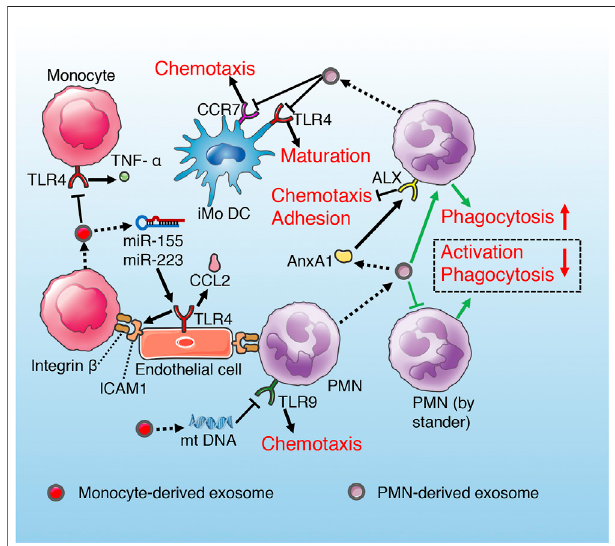
FIGURE 7 | Role of exosomes derived from monocyte and PMN in sepsis.Monocyte exosomes reduce TNF- α release ofrecipientmonocyteand PMNchemotaxis via TLRinhibition.However,exosomalmiRNAsofmonocyte promote endothelium adhesion by activating TLR. PMN-derived exosomes suppress maturation and chemotaxis of iMoDC through inhibiting CCR7andTLR4separately.PMN-derivedexosomessuppressrecipientPMN chemotaxis and adhesion to endothelium via AnxA1/ALX pathway. In addition, exosomes secrete by PMN promote anti-in fl ammatory cytokines release of recipient PMN, while induce immune anergy of bystander PMN (green